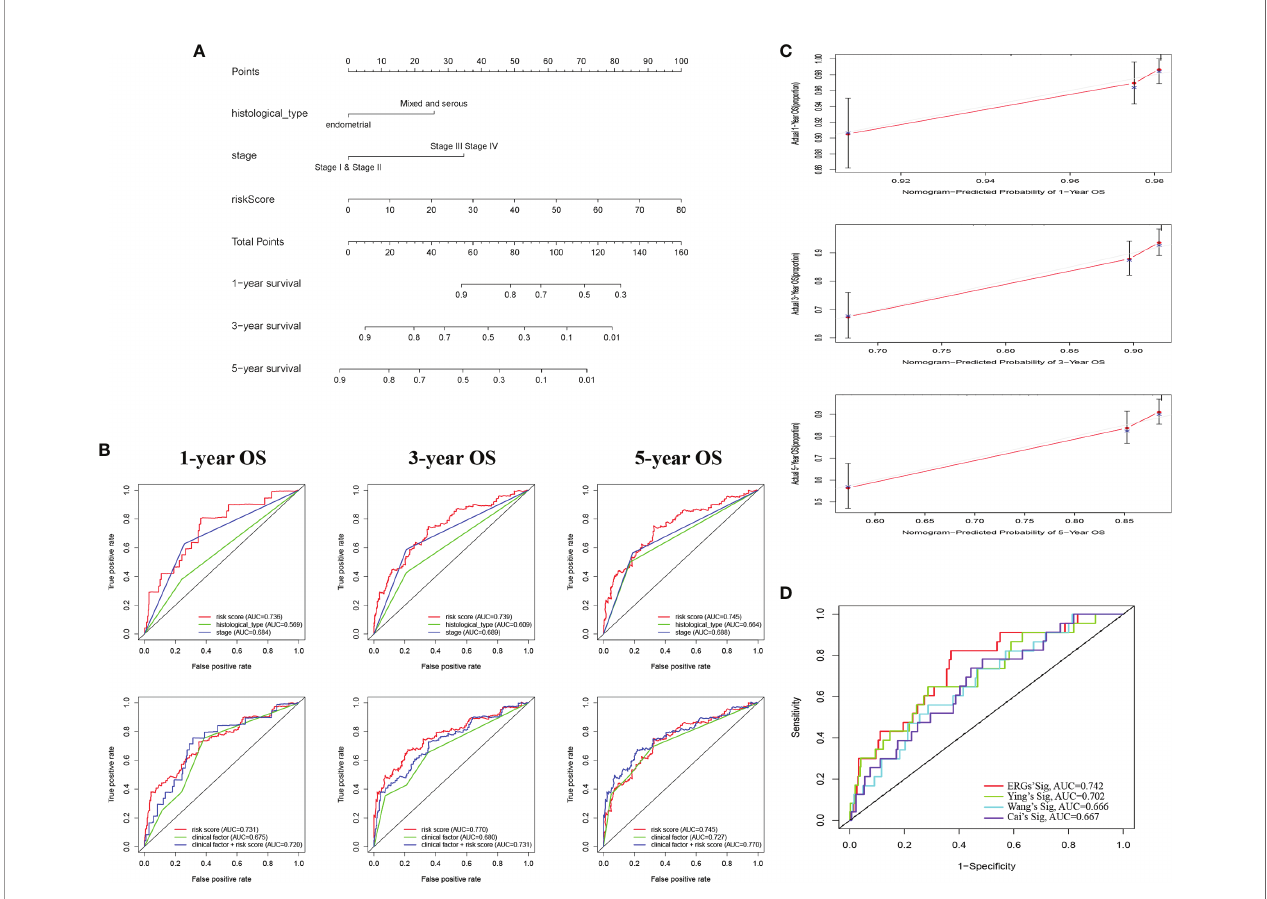
FIGURE 3 | Construction of a nomogram for survival prediction of EC patients. (A) The nomogram combining signature with clinicopathological features (histological_type, clinical stage, and risk score). (B) ROC curves of 1-, 3-, and 5-year overall survival (OS), indicating that the ERG-based signatures had better predictive ability than other clinical factors. Furthermore, when combined risk score with clinical factors for analysis, the AUC values of 5-year OS increased further, which suggested that the nomograms had superior predictive capacity for the long-term prognosis of EC. (C) Calibration plot showing that nomogram-predicted survival probabilities corresponded closely to the actually observed proportions. (D) The AUC for ERGs and the existing EMT-related signatures. EC, endometrial cancer; ROC, receiver operating characteristic; EMT, epithelial – mesenchymal transition; ERG, EMT-related gene; AUC, area under the